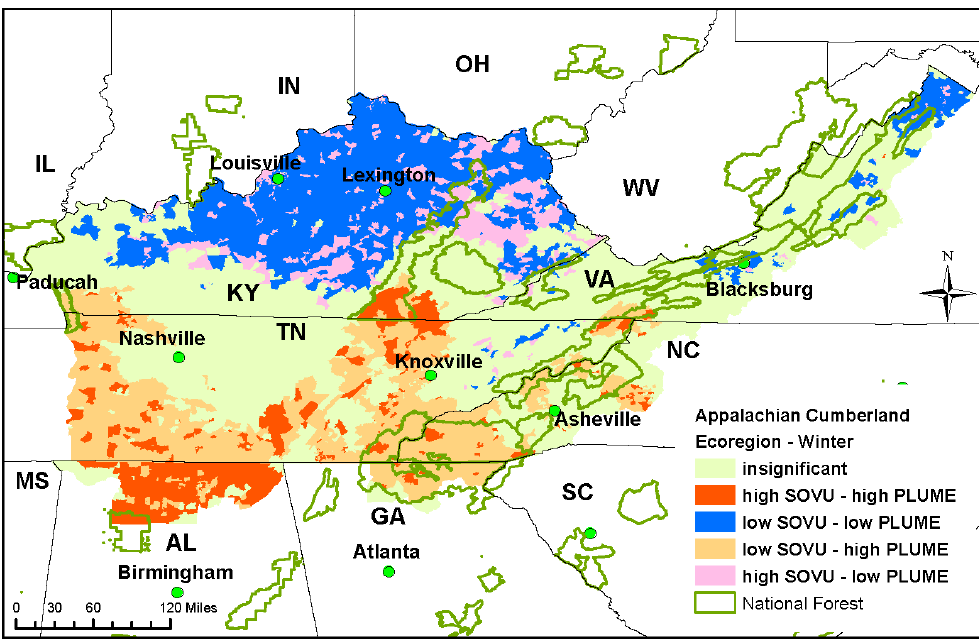
Figure 4. Bivariate LISA mapping of social vulnerability and smoke plume in the Appalachian-Cumberland ecoregion—winter.